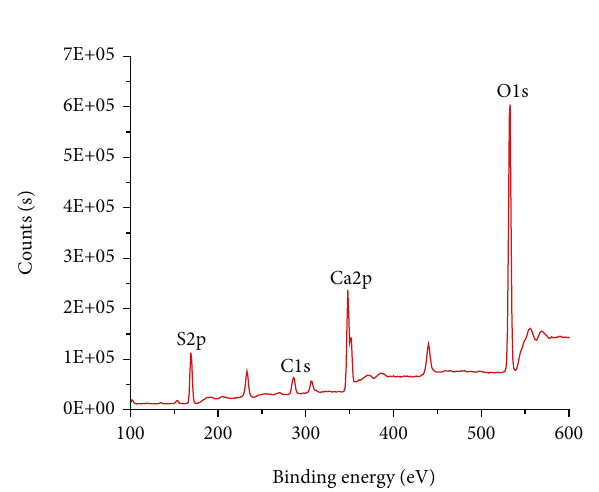
Figure 5: JW-BK132F instruments.